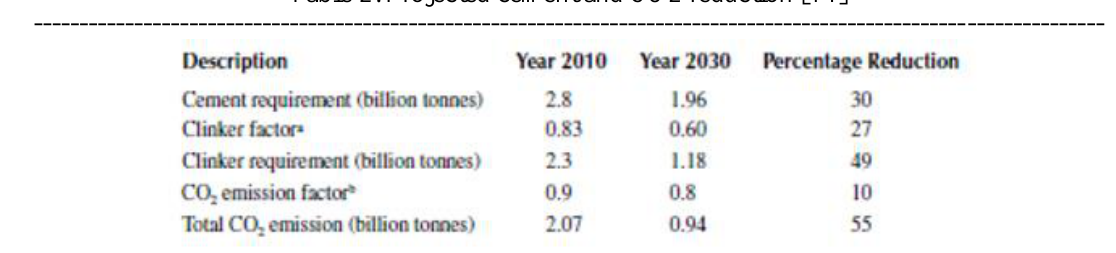
Table 2. Projected cement and CO2 reduction